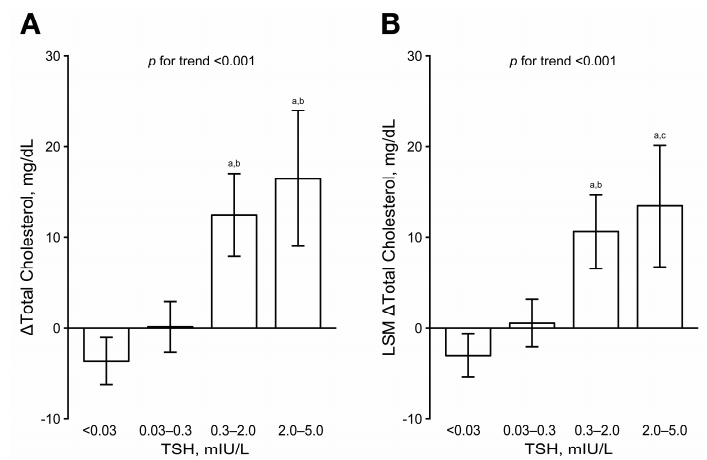
Figure 1. Preoperative-to-follow-up changes (Δ) in total cholesterol level according to TSH group. ( A ) Unadjusted means with intergroup comparisons by analysis of variance and Tukey’s test. ( B ) Least-square means, adjusted for age, follow-up duration, and preoperative cholesterol level, with intergroup comparisons by analysis of covariance and Tukey’s test. a p < 0.001 vs. TSH < 0.03 mIU/L; b p < 0.001 vs. TSH 0.03–0.3 mIU/L; c p < 0.01 vs. TSH 0.03–0.3 mIU/L. LSM, least-square mean; TSH, thyroid-stimulating hormone. Table 2. Association between follow-up TSH level and ∆ total cholesterol (mg / dL). Table 2. Association between follow-up TSH level and ∆total cholesterol (mg/dL) . Model n β (SE) p Value Model n β (SE) p value Model Model 1 1092 6.45 (1.11) <0.001 Model 2 1092 5.15 (1.03) <0.001 Model 3 1092 5.15 (1.03) <0.001